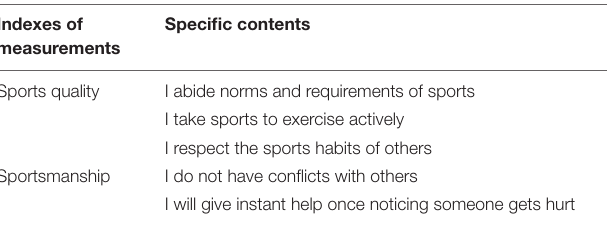
TABLE 4 | Core issues of QS for sports morality of college